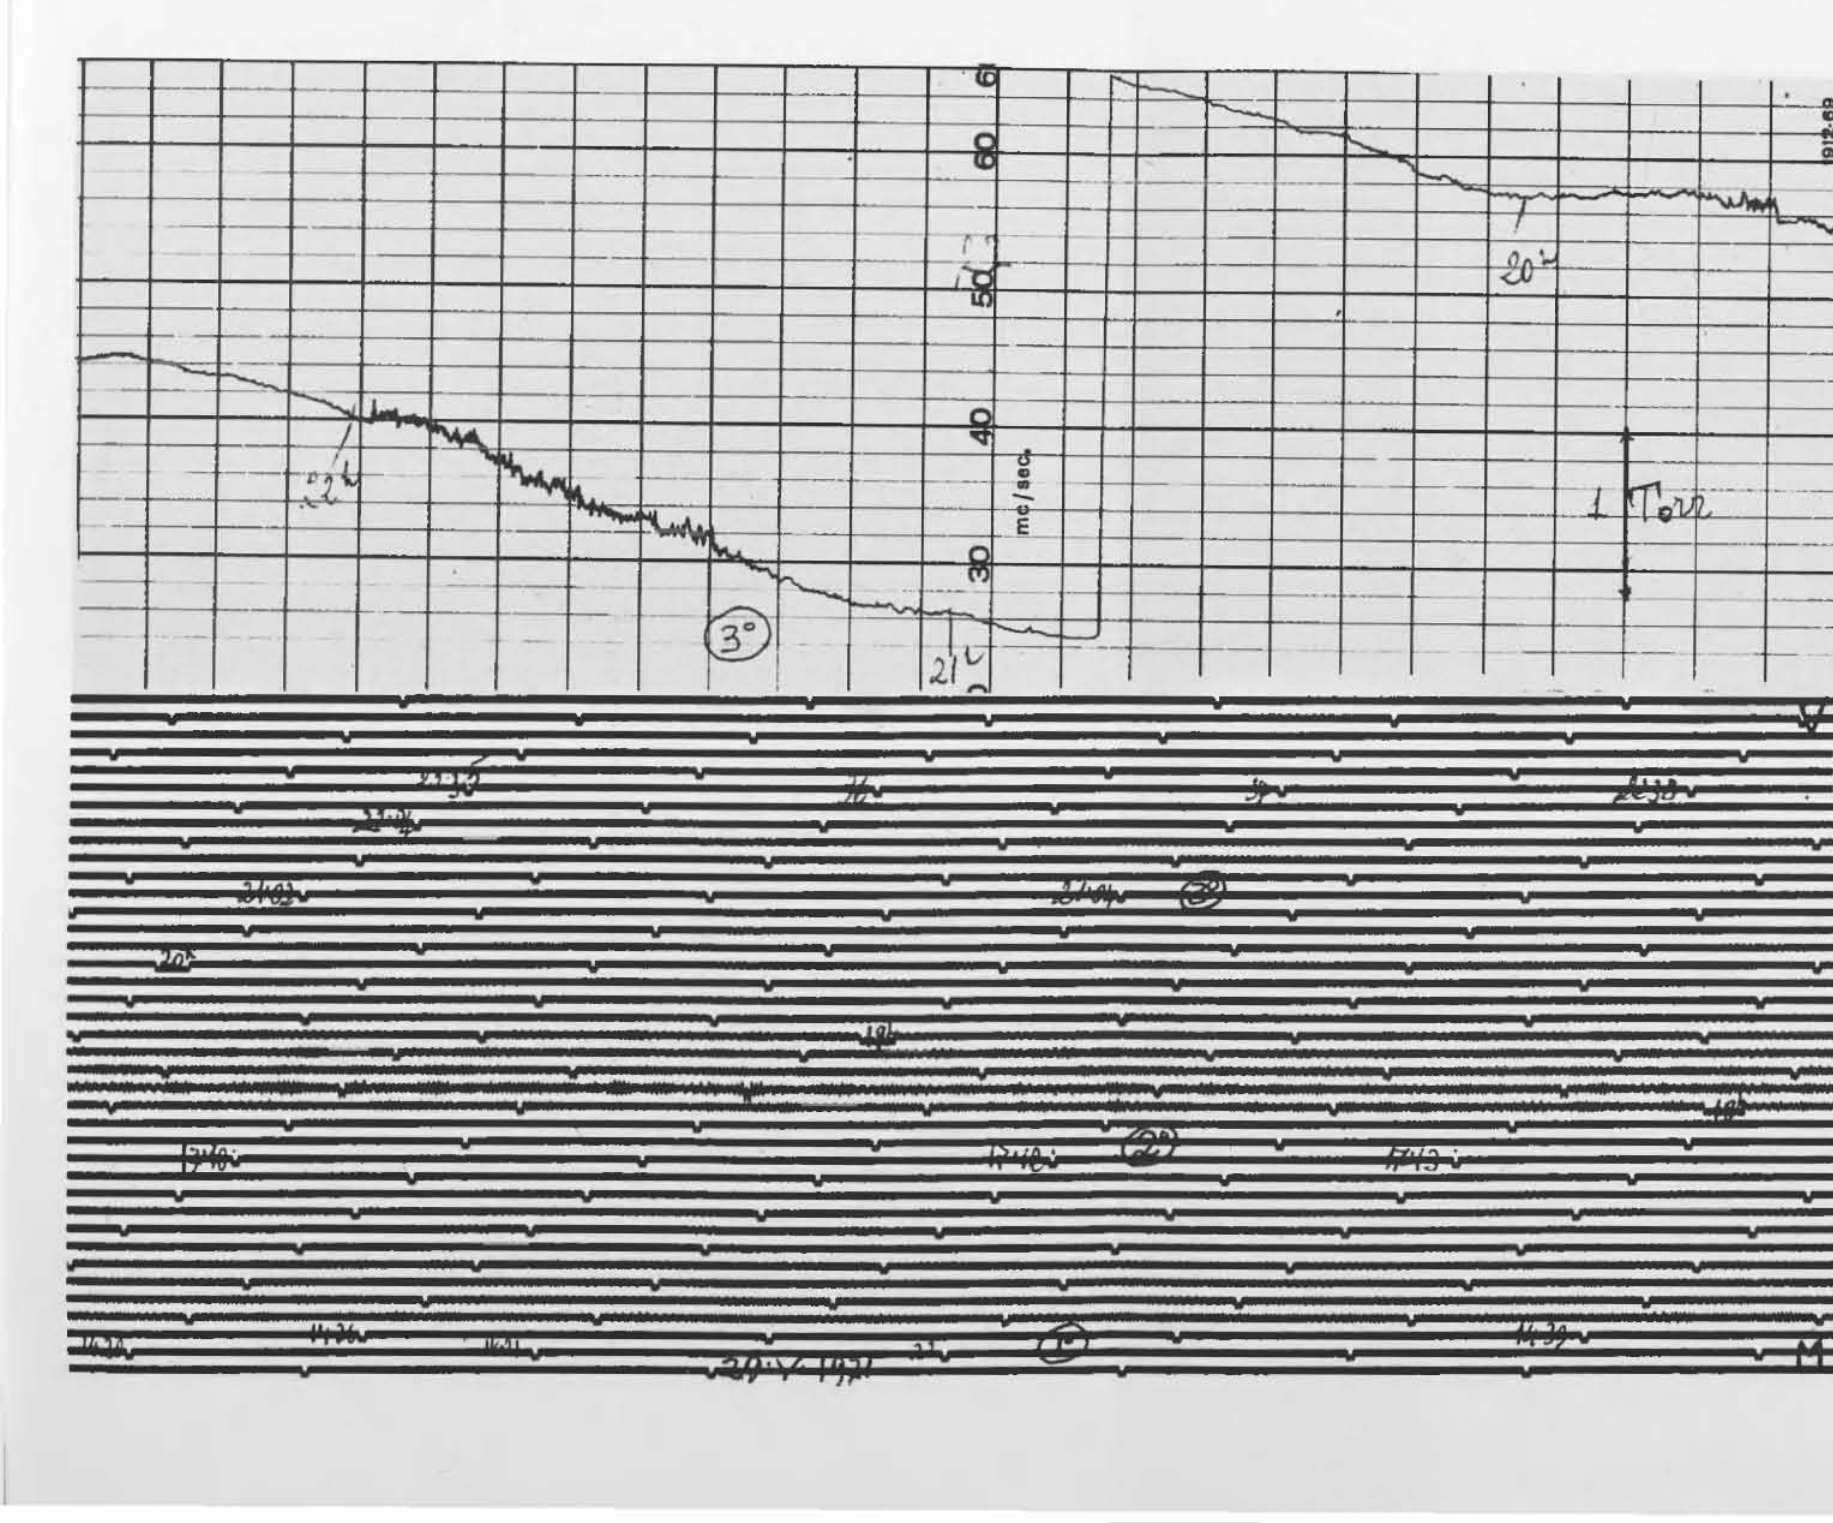
I ; of light antl very quick OBcil1ations, Ula second of Wllil"ll appears }jY fa.r t116